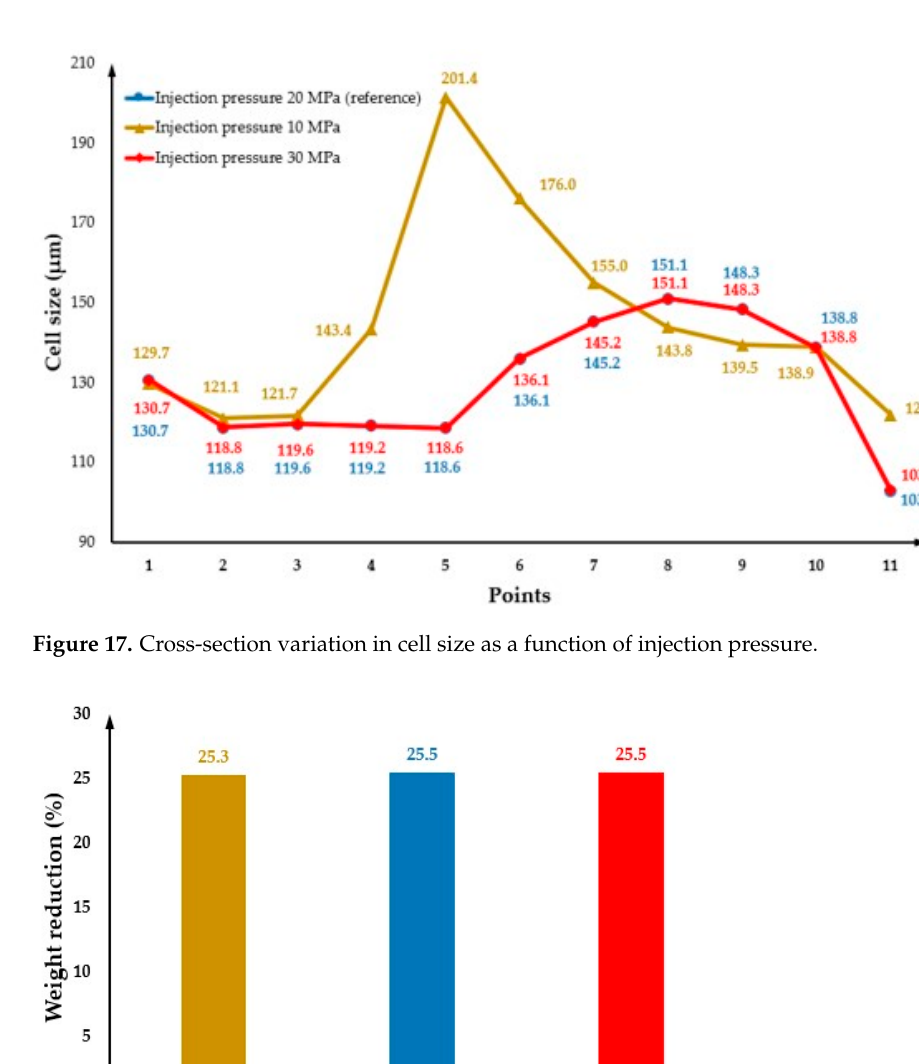
Figure 16. The cell distribution on the part considering an injection pressure of 10 MPa ( a1 , b1 ) and 30 MPa ( a2 , b2 ).